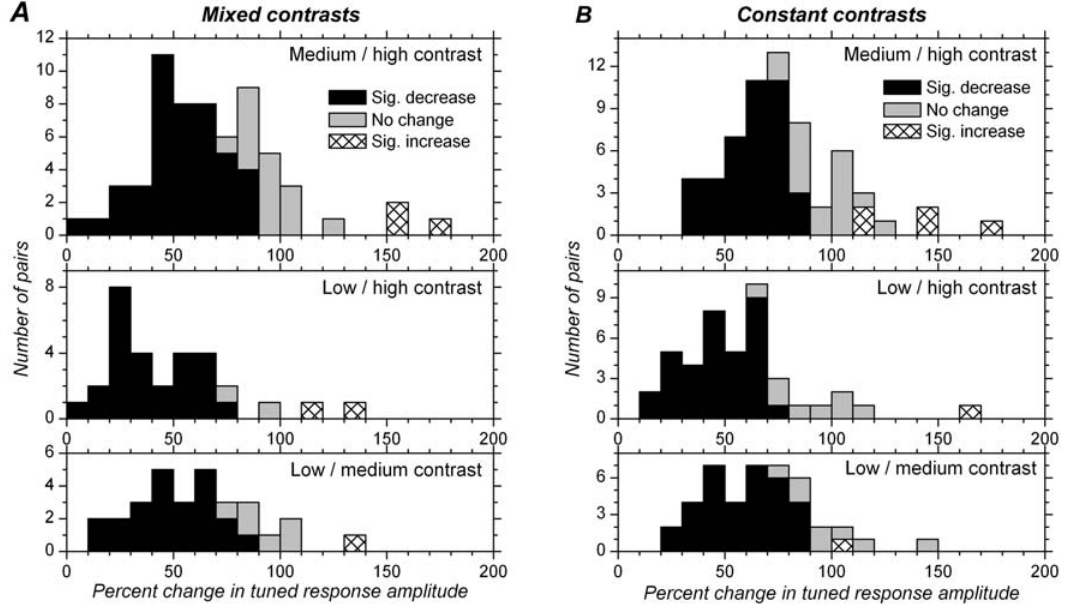
Figure 4. Distribution of changes in tuned response amplitude with different contrasts. A. Mixed contrasts. B. Constant contrasts. Tuned response amplitude for medium contrast is expressed as a percentage of the tuned response amplitude at high contrast in the upper histograms. Tuned response amplitude for low contrast is expressed as a percentage of the tuned response amplitude at high contrast in the middle histograms, and as a percentage of the tuned response amplitude at medium contrast in the lower histograms. 100% on x -axis corresponds to no change in response amplitude. Relative to 100%, all distributions are shifted to the left, indicating decreased response strength with decreased contrast in nearly all cases. Black bars correspond to significant decreases, and hatched bars to significant increases in response amplitude, tested at the single cell level (p , 0.05, t test). In the vast majority of cells, the response amplitude was significantly lower when contrast was decreased.